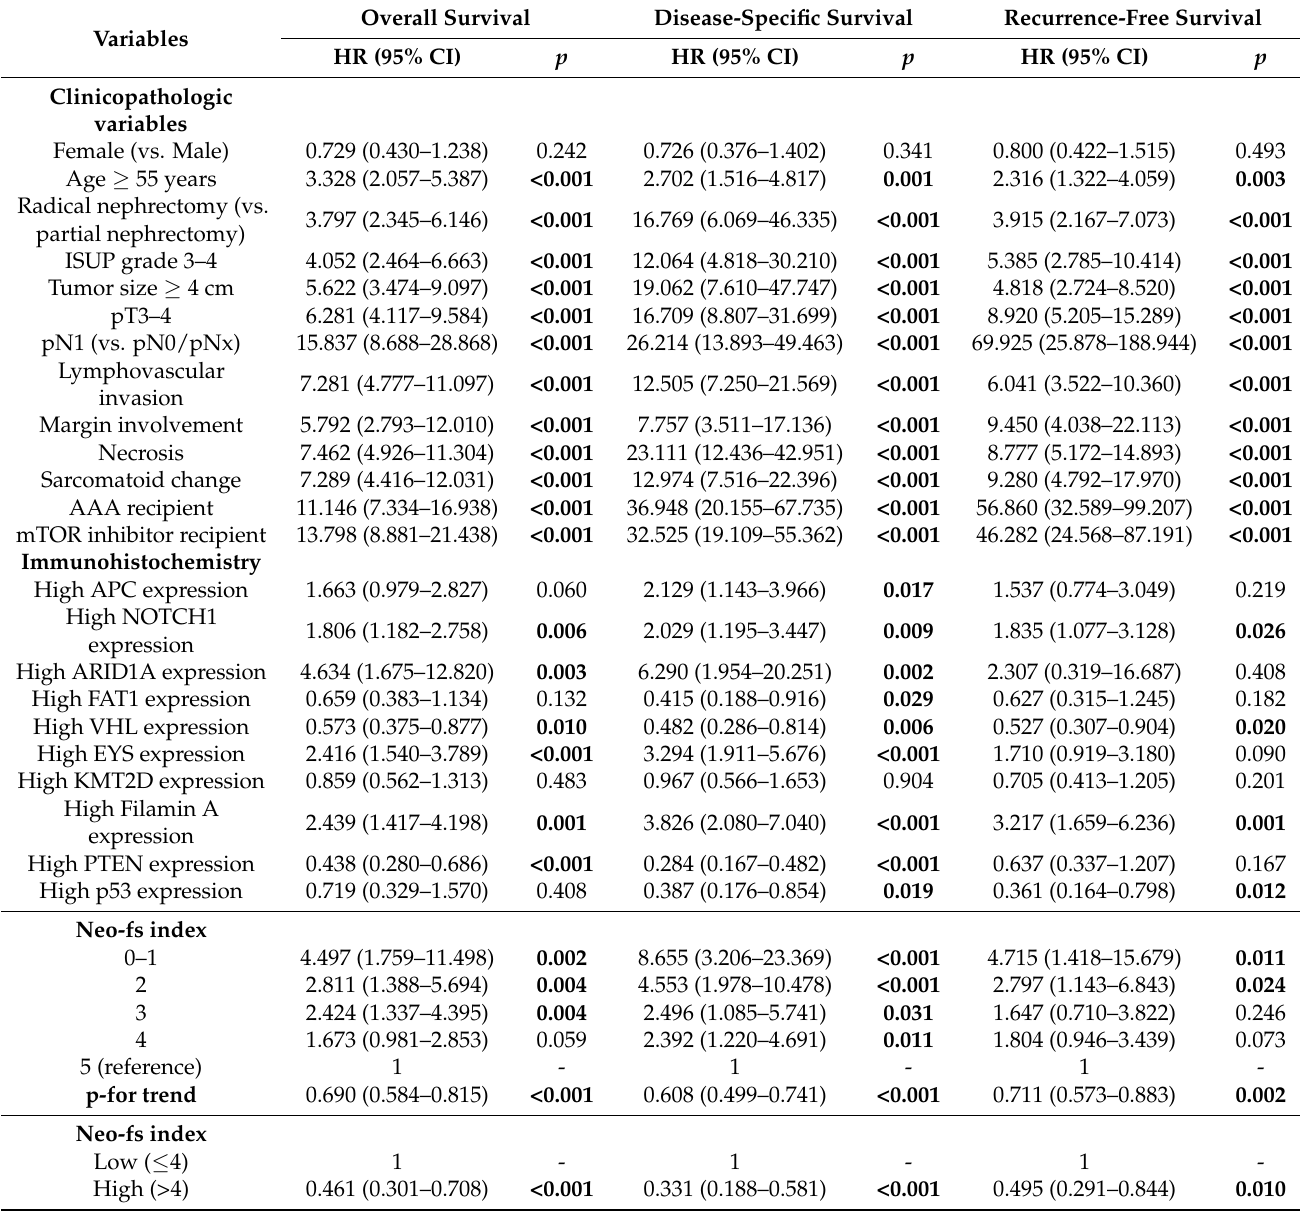
Table 2. Univariate analysis to identify a correlation between survival and clinicopathological factors and immunohisto- chemical results in patients receiving anti-angiogenic